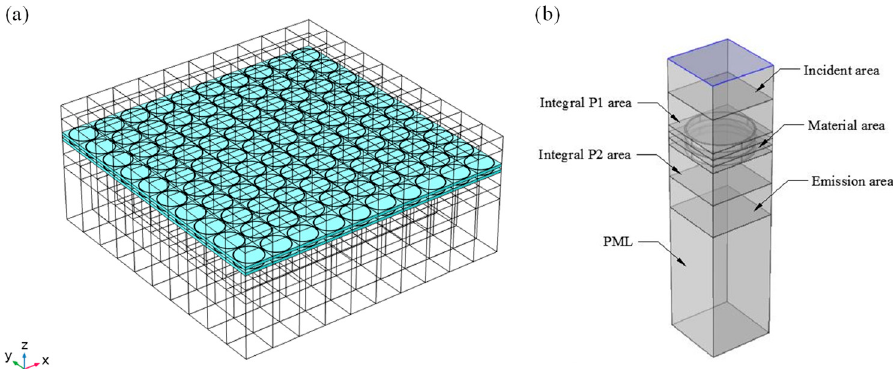
Figure 3. Sound transmission loss (STL) simulation model: ( a ) is the STL model of the finite structure and ( b ) is the partition description of the STL model.